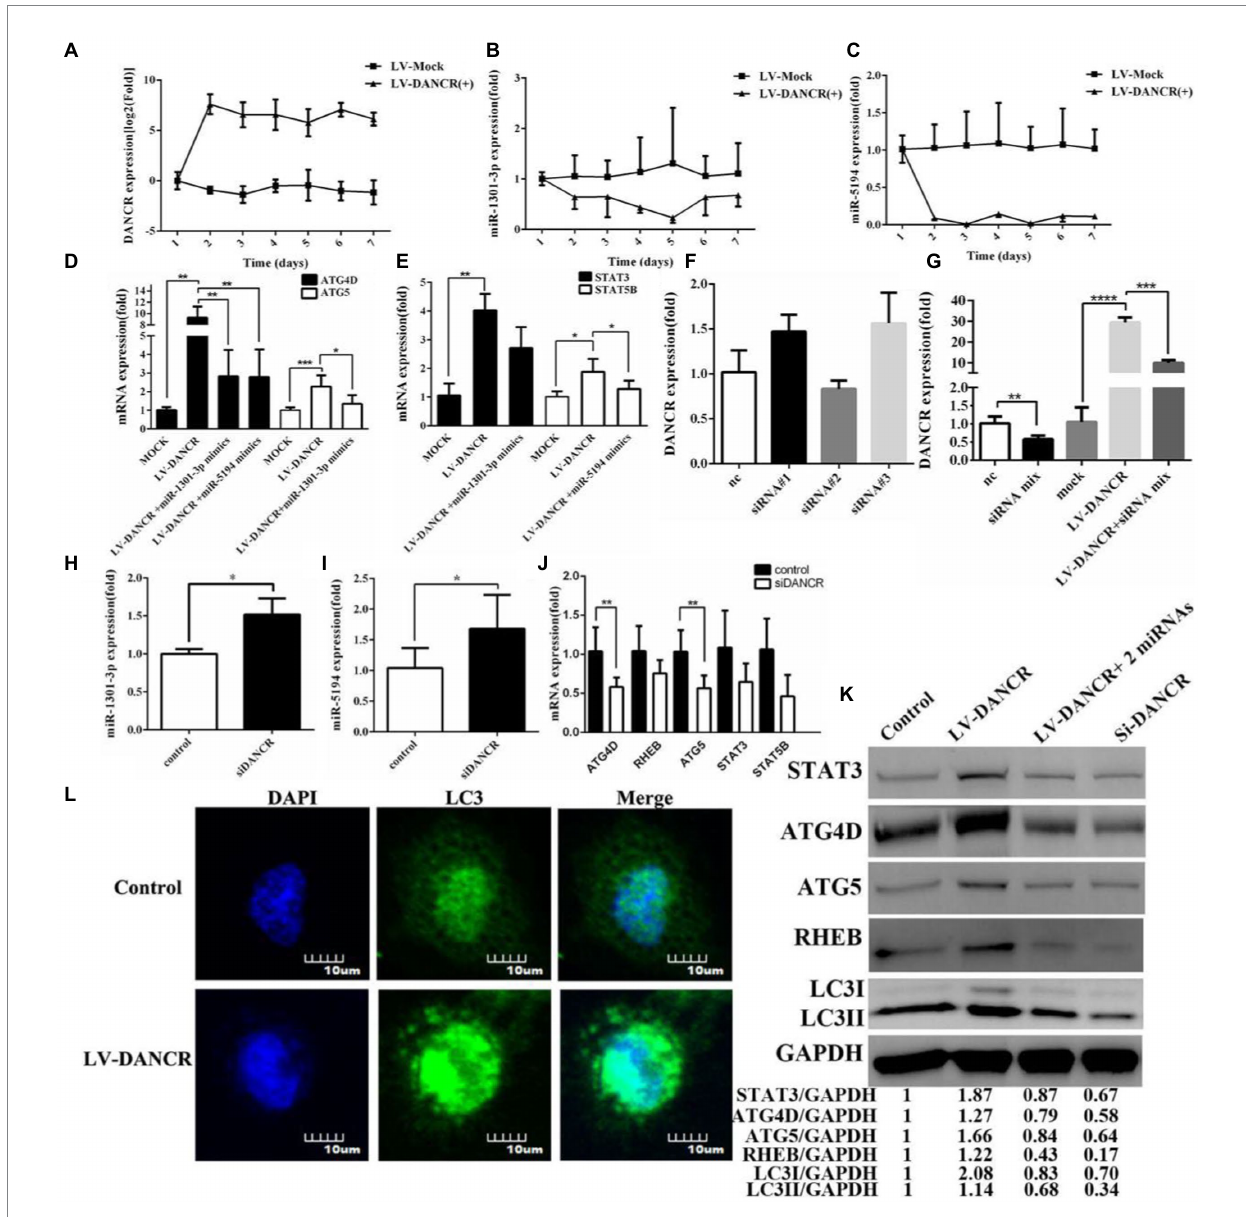
FIGURE 5 DANCR induced autophagy by sponging miR-1301-3p/miR-5194. (A–C) The PMA pretreated THP-1 cells were transfected with lentivirus encoding DANCR for 3 days. After that, the cells were harvested every 24 h for a week. The expression of DANCR (A) , miR-1301-3p (B) , and miR-5194 (C)